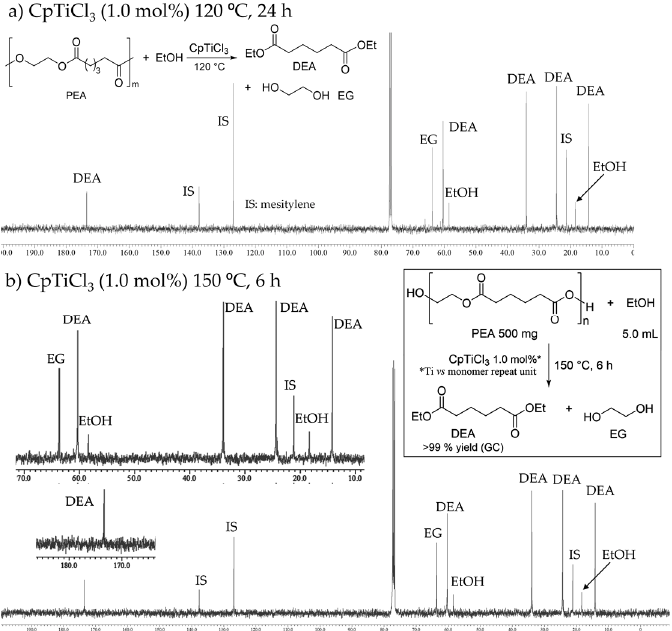
Figure 1. 13 C NMR spectra (in CDCl 3 at 25 °C) for transesterification of poly(ethylene adipate) (PEA) with ethanol by CpTiCl 3 (1.0 mol%). Conditions: ( a ) CpTiCl 3 , 120 °C 24 h, ( b ) Cp*TiCl 3 , 150 °C 6 h (run 2).